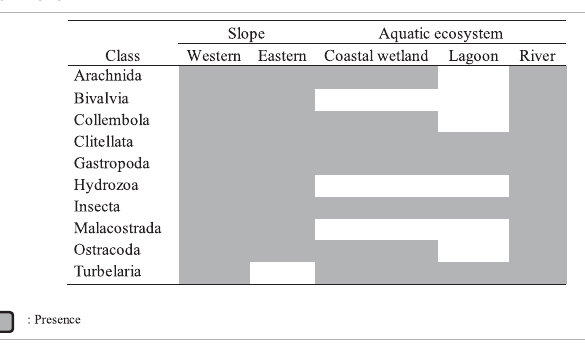
TABLE 3 | Phyla of macroinvertebrates by hydrographic slope and aquatic ecosystem, according to research studies carried out between years 1992 – 2020.